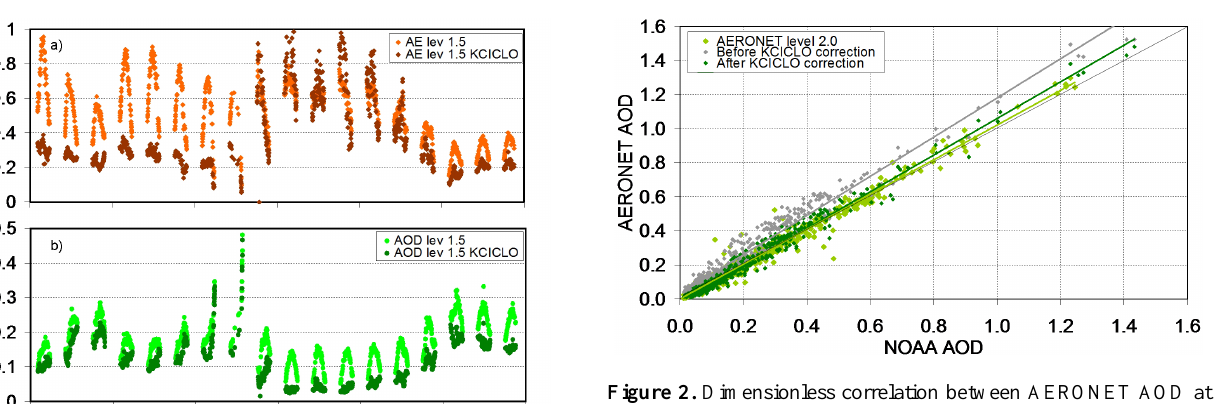
Figure 2. Dimensionless correlation between AERONET AOD at 440nm and NOAA AOD at 500nm for time coincident data (within 15 minutes). The AERONET level 2.0 data (light green) cover the period from October 2006 to February 2009. The AERONET level 1.5 data from November 2007 to June 2008 are shown before (grey) and after (dark green) applying the KCICLO correction. Each data set is shown together with their linear regression line. The solid black line is the 1:1 reference